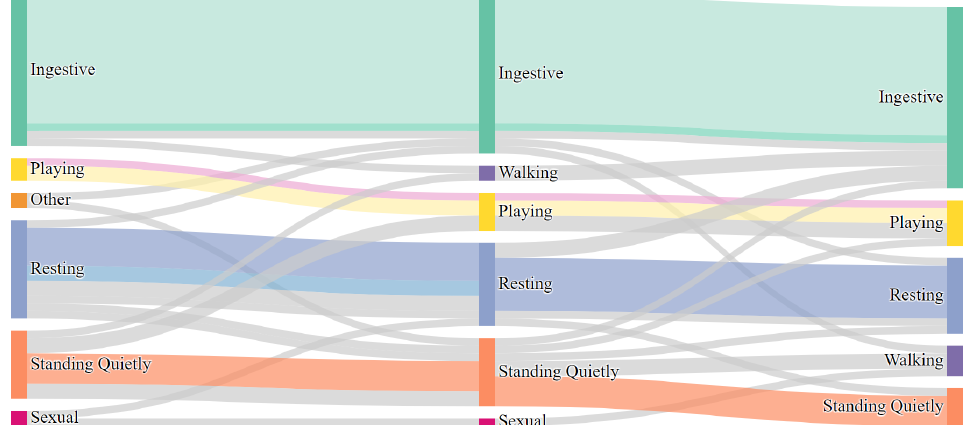
Figure 7. Flow of occurrences of E/M that did not change behavioral category before, during, and after E/M. The Sankey diagram, while originating as a way to show energy or materials flows through systems, can also be used to visualize a temporal sequence of events [48] or trajectory of a population through stages [49]. In this diagram, nodes represent behavioral categories Before E/M, During E/M, and After E/M (left to right). Width of node is relative to number of observations. Pathways can be traced from node to node to show flow through behavioral categories over time. Here, same- colored pathways show observations with no change in behavioral category before, during, and after E/M bout. Light blue represents one observation of interrupted rest (pony disturbed by another pony). Pink represents observations of sexual play (mounting), while remainder in play category is locomotive play.